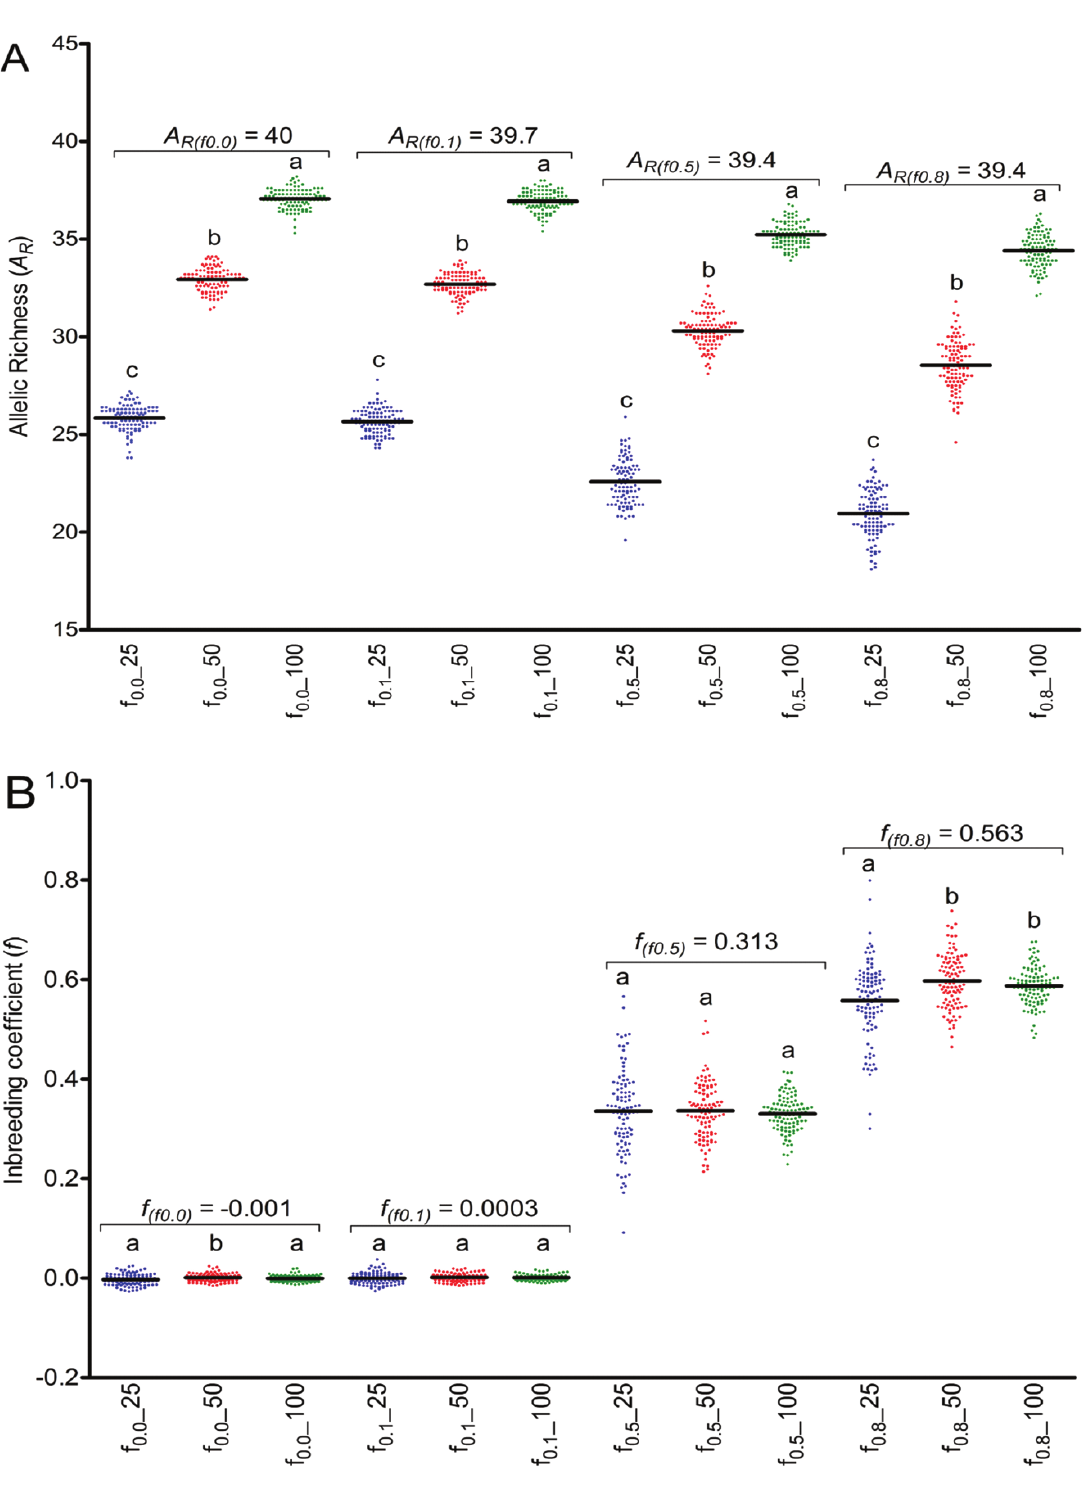
Figure 1 - Dispersion graphs of the genetic parameters estimated for the different sample sizes and mating systems tested. (A) Estimations of allelic richness. (B) Estimations of inbreeding coefficient. The mean of each estimation is represented by the black lines while dots represent each individual replicate of the